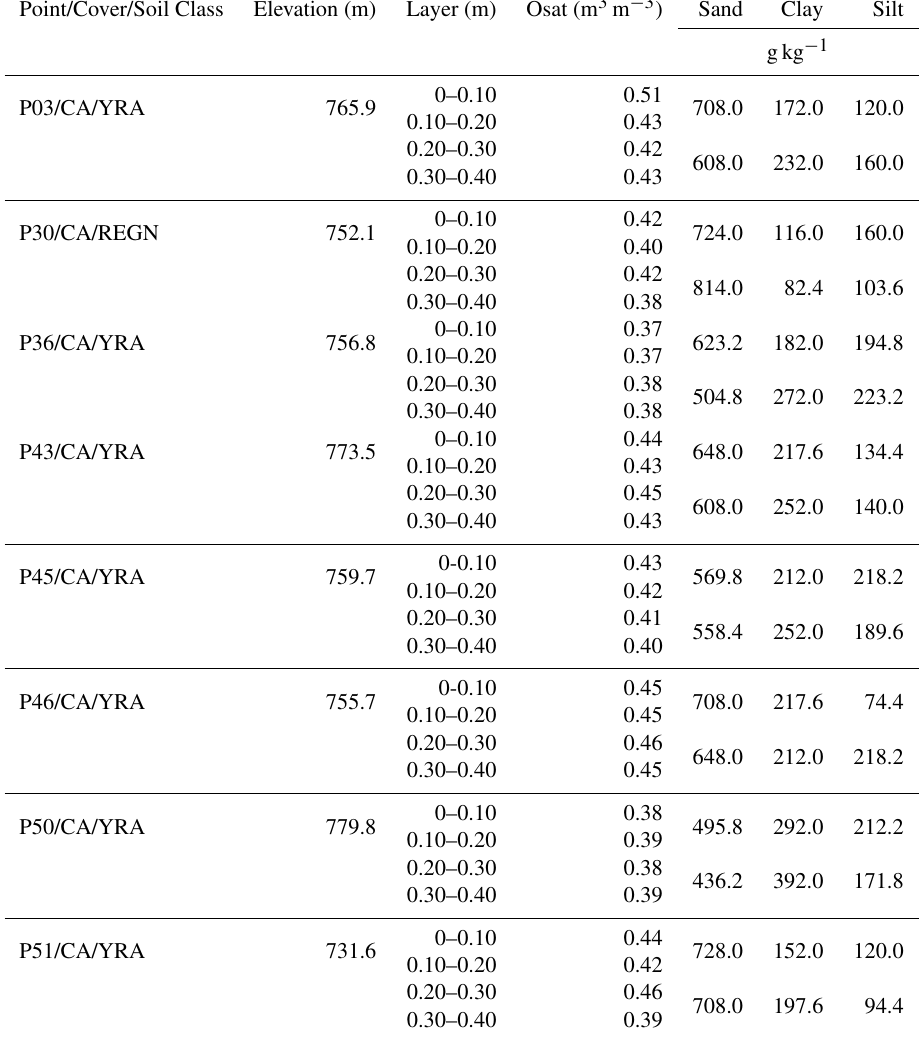
Table 2. Physical characteristics of the soil profile for the different locations of Diviner – 2000 ® access tubes. Caatinga land